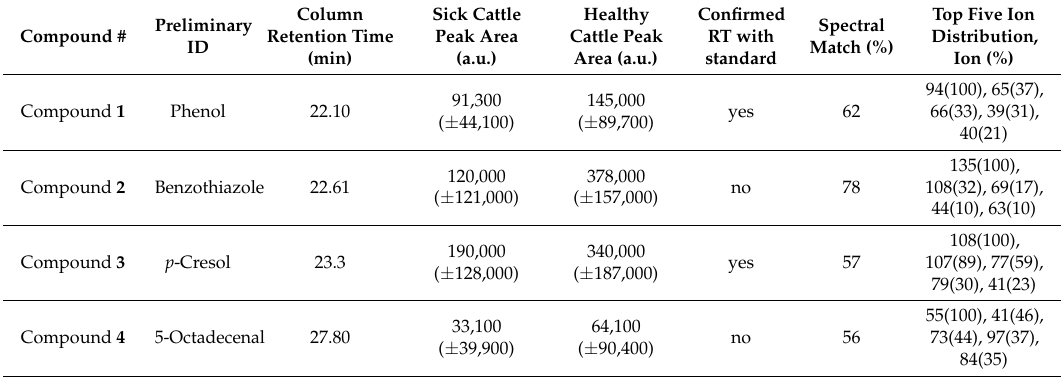
Table 1. Preliminary compound identification for markers in nasal swab samples (Figure